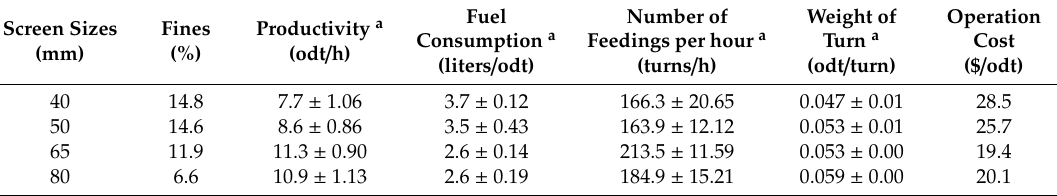
Table 1. Average productivity, in oven dry ton (odt) per hour, fuel consumption (liter per odt), number of feedings per hour (turn per hour), weight of turn (odt per turn), and cost in dollars per oven dry ton (odt) depending on screen size.